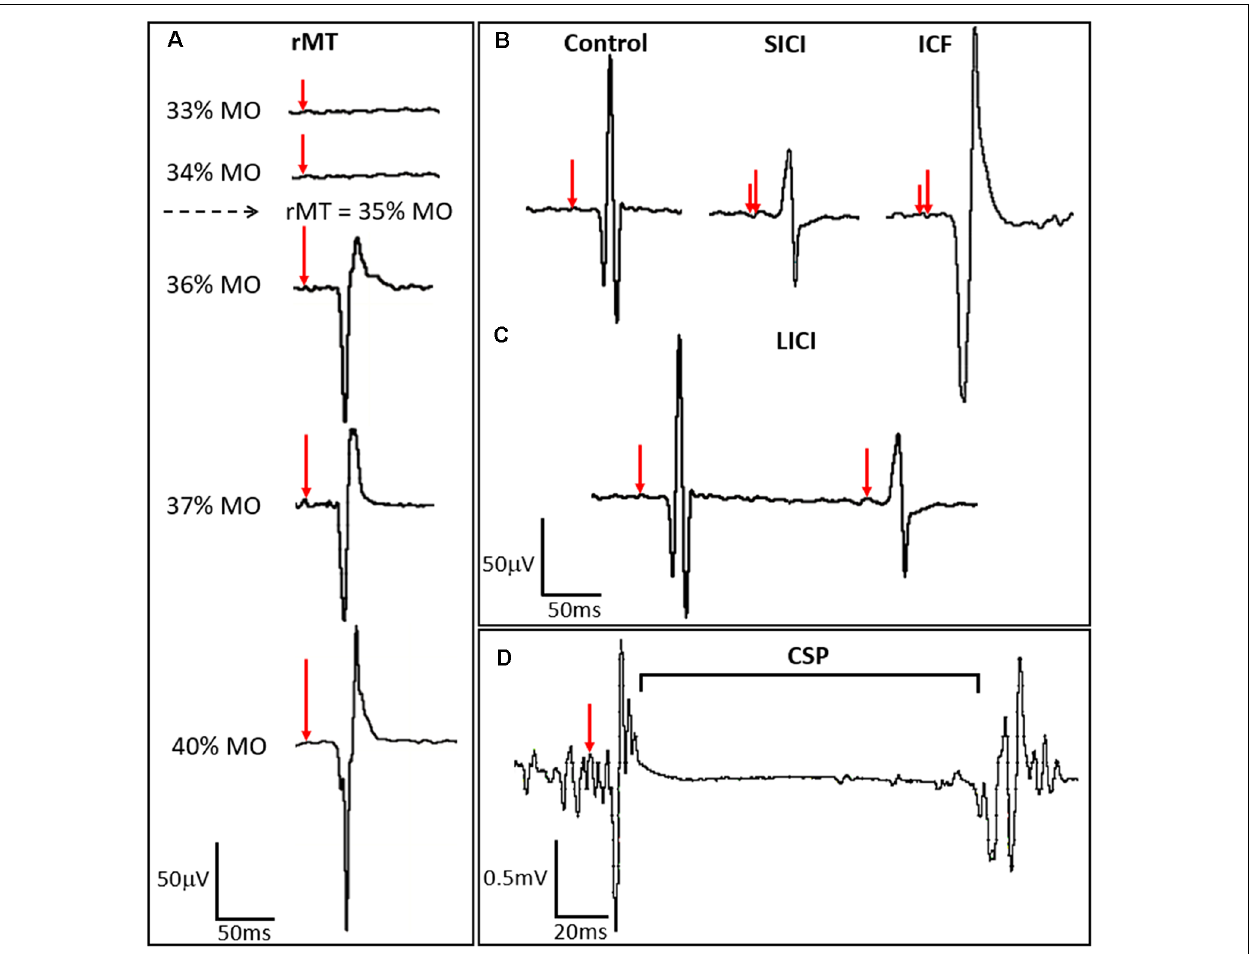
FIGURE 2 | TMS-derived metrics of motor cortex excitation and inhibition. (A) Resting motor threshold (rMT) for the APB muscle is calculated by identifying the minimum stimulus strength, measured in percent machine output (% MO), that evokes an MEP of a fixed amplitude (typically ≥ 50 µ V) in the APB at rest in a majority of trials. Stimulus strength is indicated in the left panel, with resulting MEPs shown in the right panel, where red arrows indicate the time of stimulation and percent stimulator output is proportionate to the arrow length. (B) ppTMS paradigms where a subthreshold conditioning stimulus (short red vertical line) followed by a supra-threshold test stimulus (longer red vertical line). At short inter-stimulus-intervals (ISIs) (1–5 ms) short interval intracortical inhibition (SICI) is seen with inhibition of the test MEP by the antecedent conditioning stimulus. At longer ISIs (10–20 ms), test MEP amplitude is enhanced relative to the control MEP, such that ICF is seen. (C) Still longer ISIs (50–300 ms) are applied with two suprathreshold stimuli in LICI protocols where the MEP resultant from the test stimulus is predictably lower in amplitude than the preceding MEP resulting from the conditioning stimulus. In (D) the cortical silent period (CSP), interruption of ongoing electromyography (EMG) activity for a voluntarily contracting target muscle, occurs following single-pulse TMS